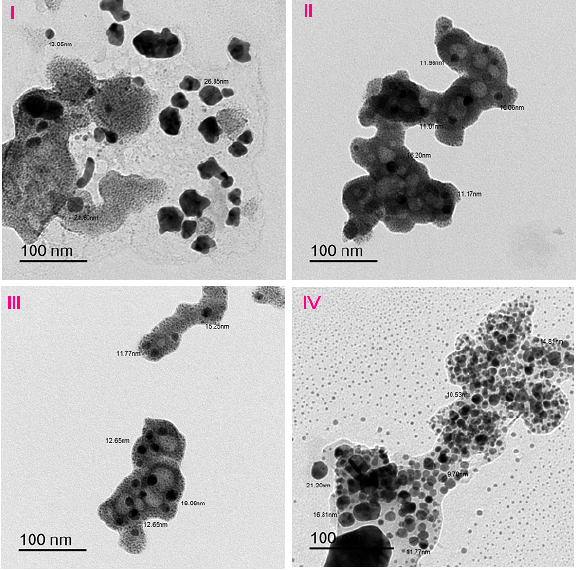
Figure 5. The TEM images of the ( I ) Mn(II), ( II ) Cu(II), ( III ) Co(II), and ( IV ) Ni(II)–Gpn complexes.